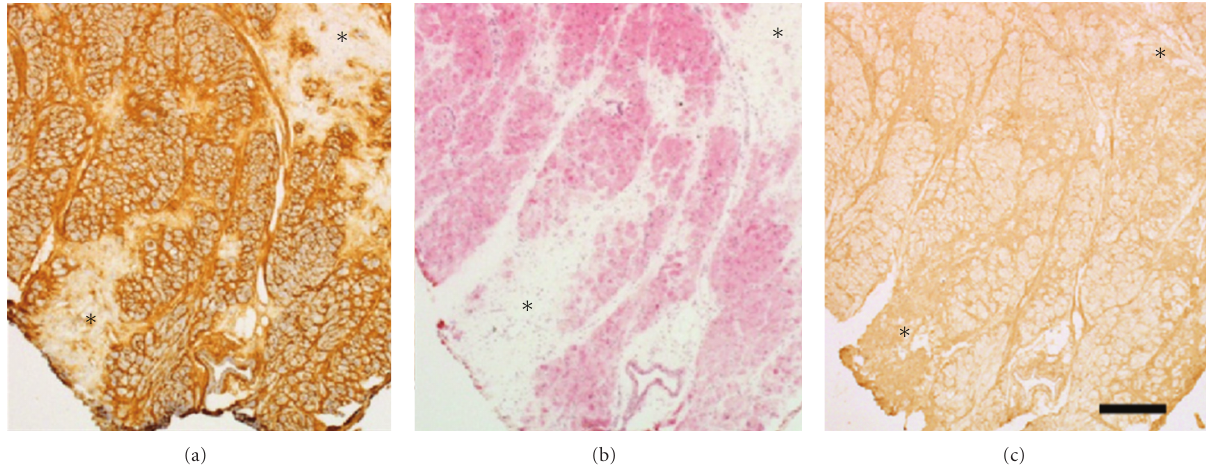
Figure 1: Serial sections from patients with HCM stained with HA-binding probe (a), hematoxylin-eosin (b), and for visualization of collagen I (c). The fibrotic “scars” (marked ∗ ) show weak or no HA staining (a) but abundant collagen I staining (c). The bar in C represents 500 µ m.